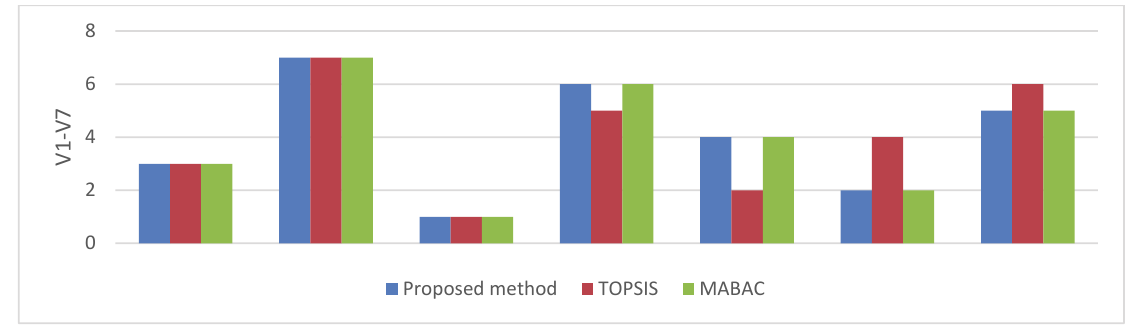
Fig. 2. Ranking of scooters in various